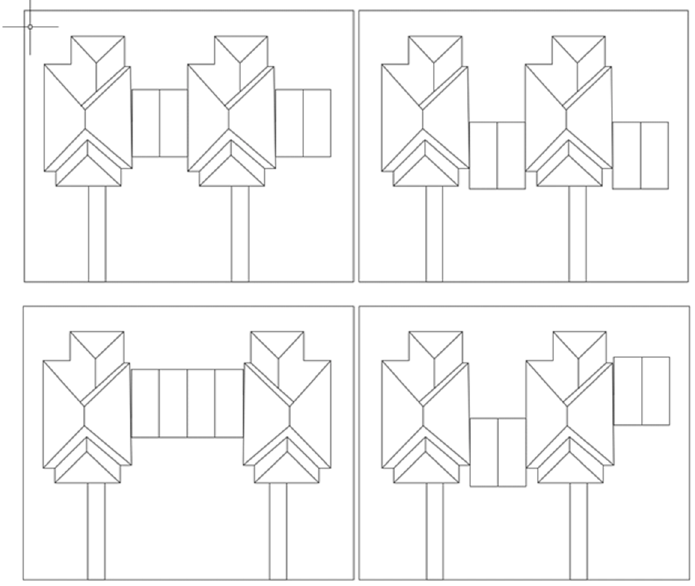
Figure 4. These four scenarios illustrate the positioning of garages in relation to the house.